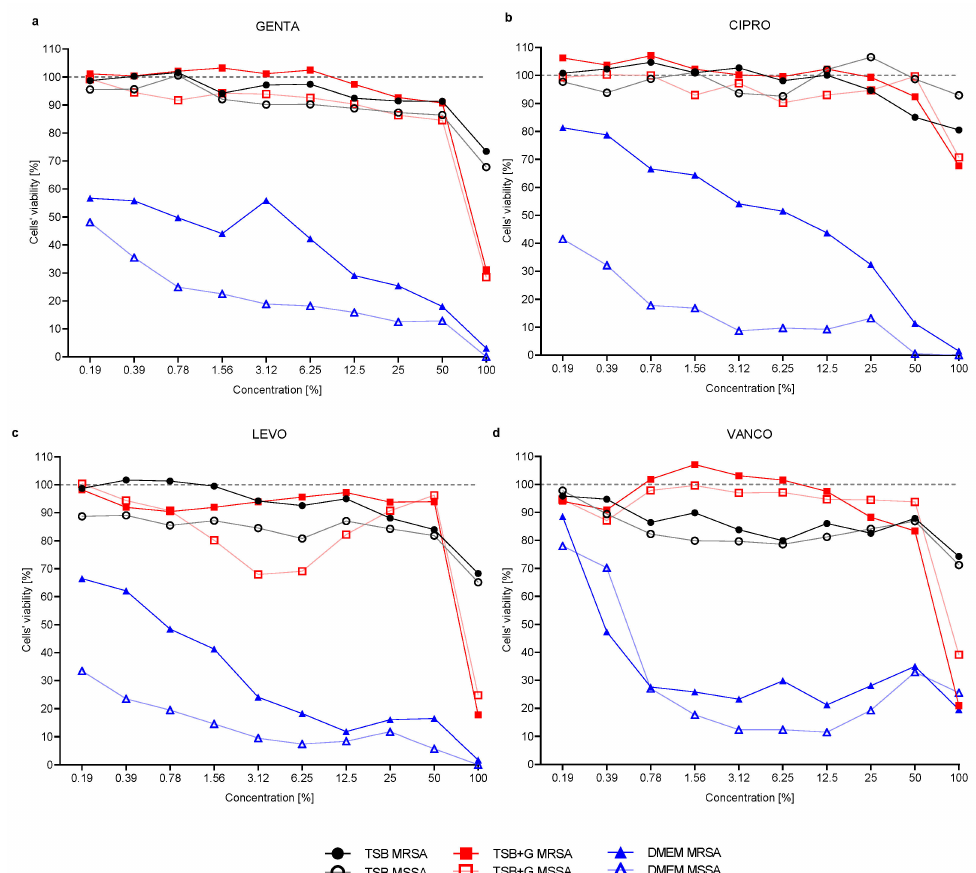
Figure 3. Viability of methicillin-susceptible MSSA and methicillin-resistant MRSA Staphylococcus aureus strains in biofilm, treated with serial dilution of antibiotic solutions: gentamycin GENTA ( a ), ciprofloxacin CIPRO ( b ), levofloxacin LEVO ( c ), and vancomycin VANCO ( d ). Biofilm was formed in three different media: tryptic soy broth TSB, tryptic soy broth with 1% glucose TSB + G, and Dulbecco’s Modified Eagle Medium DMEM.